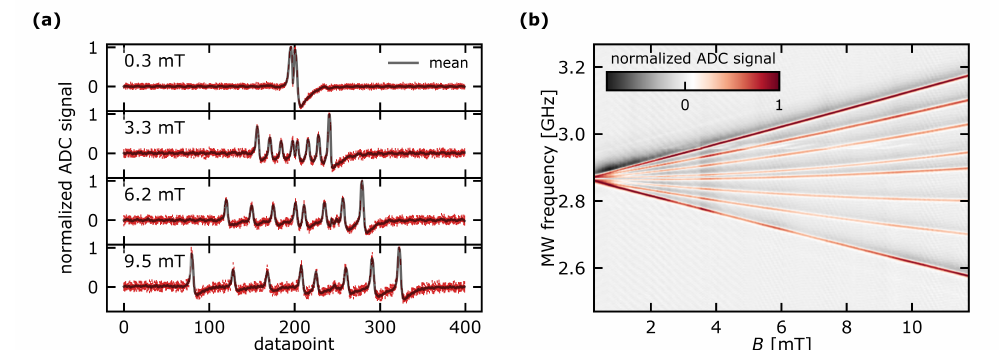
Figure 4. Exemplary visualization of the acquired data. ( a ) Ten exemplary training spectra at different magnitudes of the magnetic field. In a single ODMR spectrum, one datapoint is the mean, normalized value of four measured ADC values. Note that the dips in fluorescence are being inverted by the instrumentation amplifier. The undershoot at the right-hand side of the inverted dips can be attributed to the high-pass filter in the signal chain. ( b ) Dataset for a full sweep of magnetic